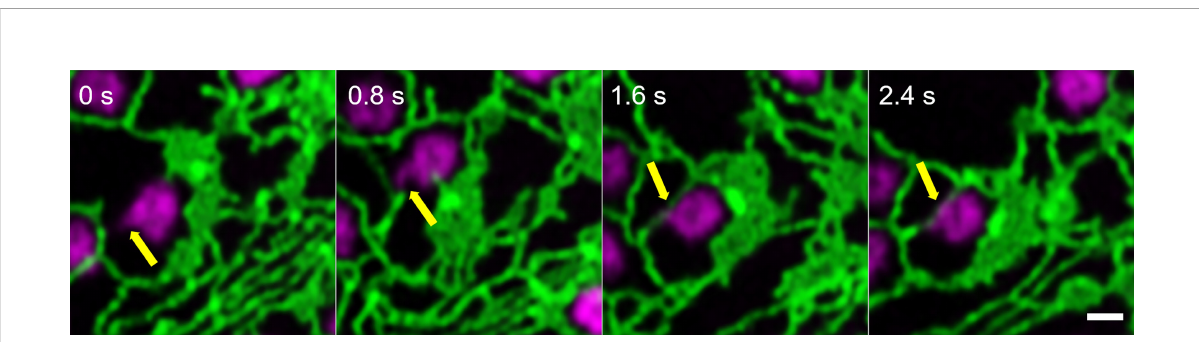
FIGURE 2 Identi fi cation of dynamic Golgi-derived tubules that connect with the ER. Golgi bodies labelled with the medial/ trans -Golgi marker ST-mRFP (in magenta) form protrusions (yellow arrow) that can also be wrapped around ER tubules (labelled with GFP-HDEL in green). Markers are expressed transiently in tobacco leaf epidermal cells. Images are shown in time intervals of 0.8 s between the frames and time points are indicated. Size bar = 1